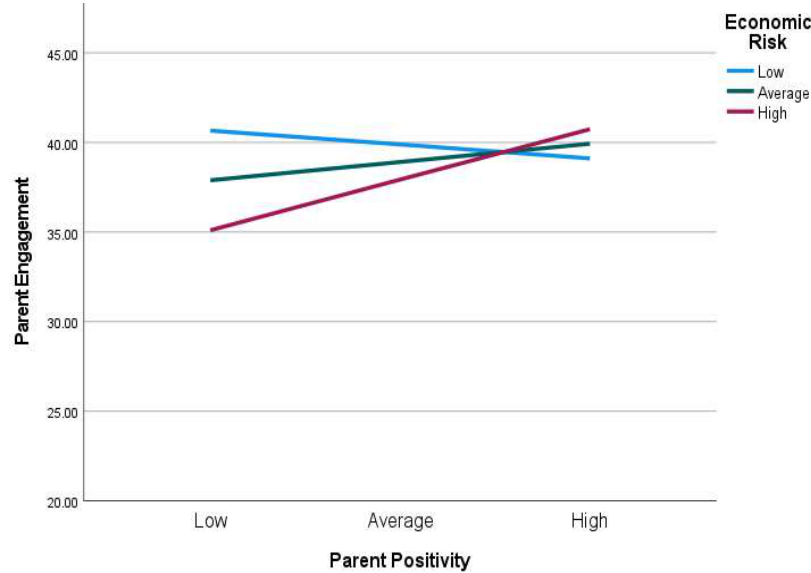
Figure 3. Parent positivity moderating the effect of economic risk on parental engagement scores. High = 1 standard deviation above the sample mean, average = sample mean, and low = 1 standard deviation below the sample mean.